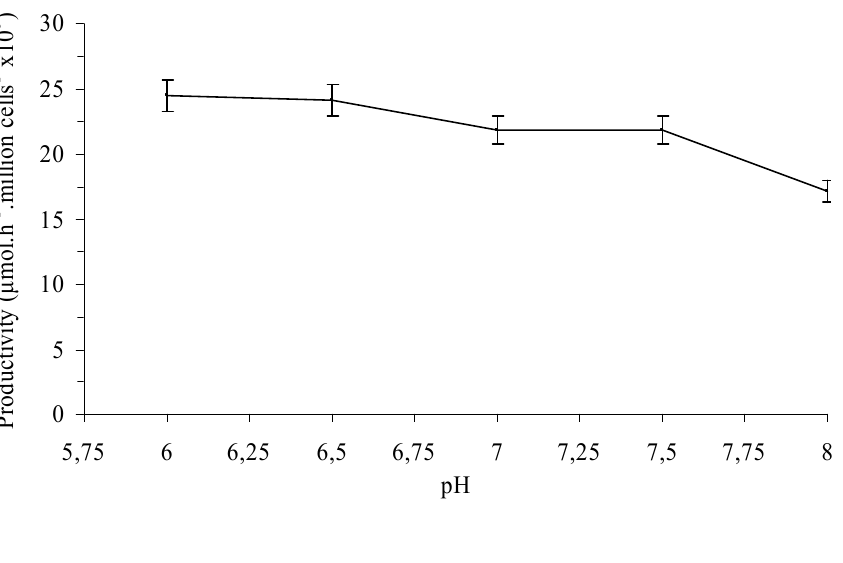
Figure. 1. Influence of pH in the productivity of deoxyadenosine by T. thermophilus HB27. Standard reaction conditions: 65ºC, 5mM deoxyuridine, 5mM adenine, 30mM sodium phosphate buffer (pH=7). Total reaction volume 4